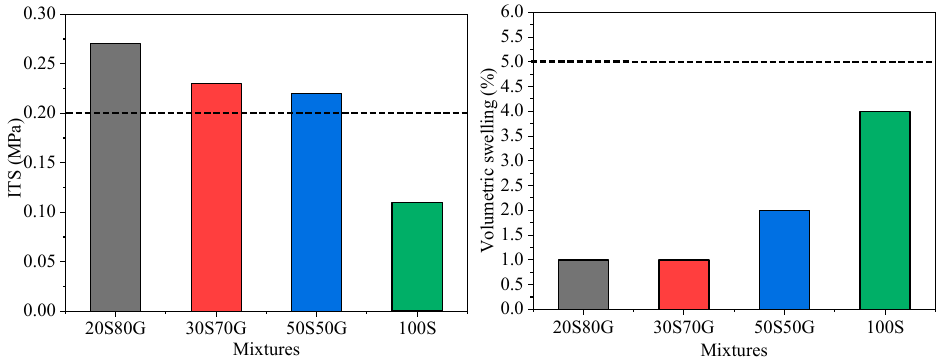
Figure 5. ITS and swelling volume after immersion in water.